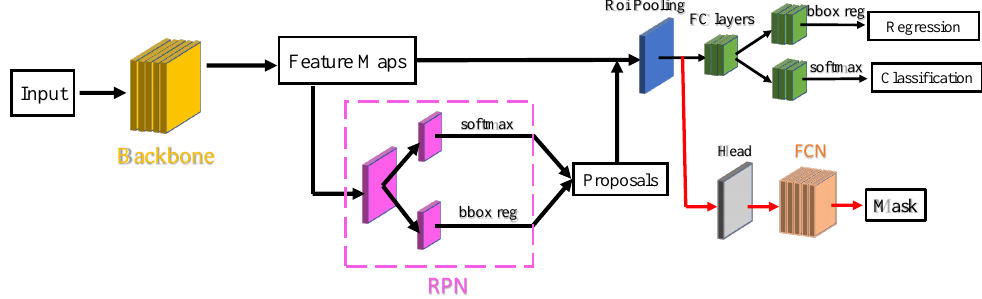
Figure 3. Structure of the adopted Mask-RCNN